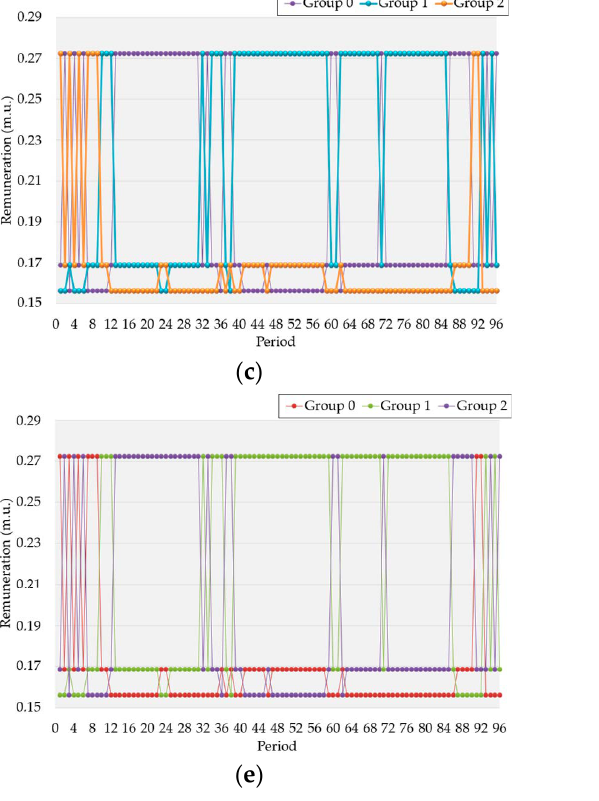
Figure 7. Contextual tariffs for case study 1 according to clustering results: ( a ) prosumers’ load flexibility remuneration per period for case study 1, ( b ) prosumers’ BES discharging remuneration per period for case study 1, ( c ) prosumers’ load flexibility remuneration per period for case study 2, ( d ) prosumers’ BES discharging remuneration per period for case study 2, ( e ) prosumers’ load flexibility remuneration per period for case study 3, ( f ) prosumers’ BES discharging remuneration per period for case study 3. The red circles highlight the same periods of Figure 5.